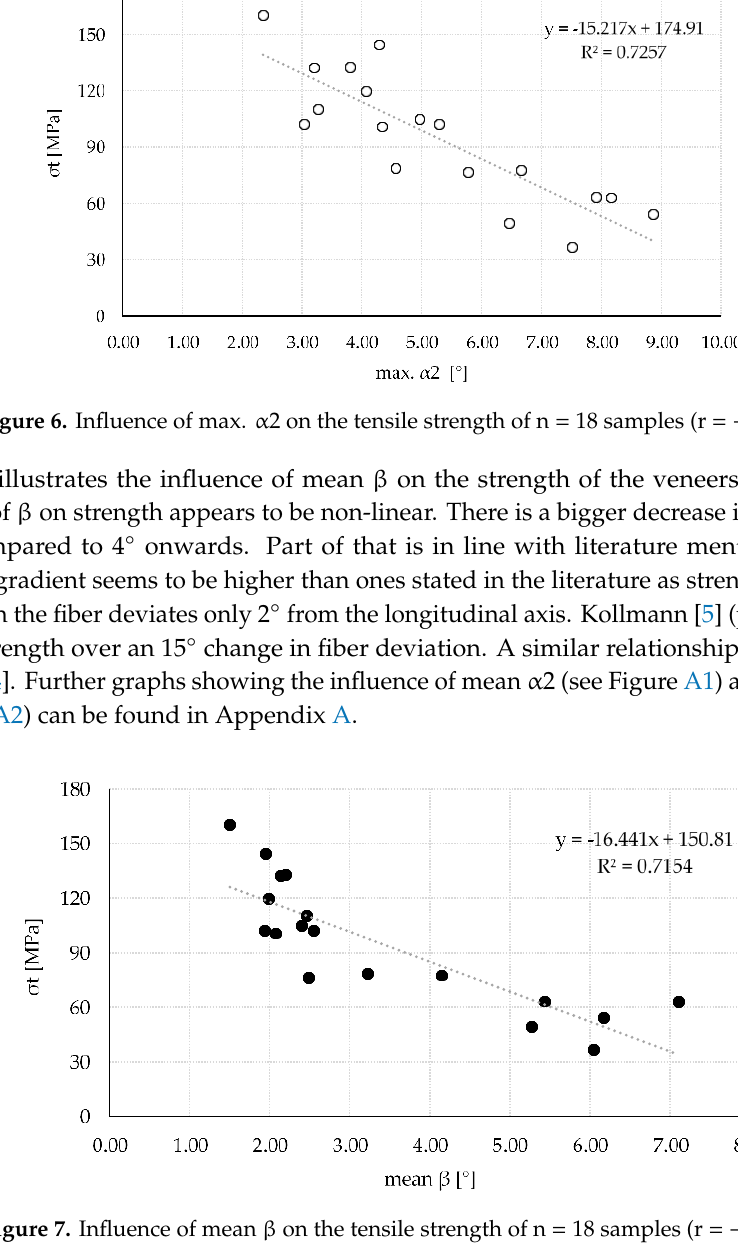
Figure 7. Influence of mean β on the tensile strength of n = 18 samples (r = −0.846).